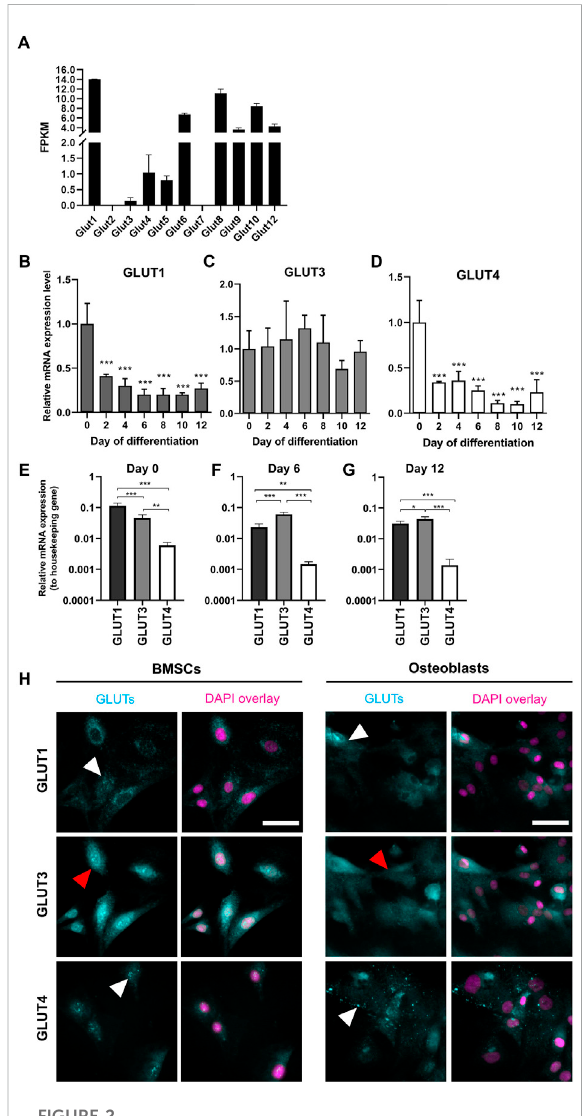
FIGURE 2 Expression pattern of GLUTs during osteoblast differentiation. Presence of GLUT transcripts in dataset of RNA- sequencing for day 2 osteoblasts (A) . Fragments per kilobase of transcript per millions reads mapped (FPKM) for each GLUT are shown. RNA-seq data cannot be used to quantitatively compare expression levels. GLUT1 (B) and GLUT4 (D) mRNA- expression levels decreased during osteoblast differentiation when compared to BMSCs (Day 0). GLUT3 (C) expression remained relatively stable. GLUT1 was the most expressed in BMSCs (E) , whereas GLUT3 was expressed in differentiated osteoblasts (F,G) . GLUT4 was the least expressed throughout the differentiation. Cyclophilin B was used to normalize the mRNA levels. Cultures were repeated 3 times and representative images are shown. When we stained GLUT-proteins (cyan) in BMSCs and day 6 osteoblasts, GLUT1 and GLUT4 appeared to be on intracellular vesicles (white arrows), whereas GLUT3 appeared to be more evenly distributed on cellular membrane (red arrows) (H) . Nucleus is shown with magenta, scalebar 50 μ m. Note that GLUT1 and GLUT3 staining was performed as double-staining on same cells, and images are pseudo-coloured. p -values: * p < 0.05, ** p < 0.01 and *** p < 0.001 (One way ANOVA).